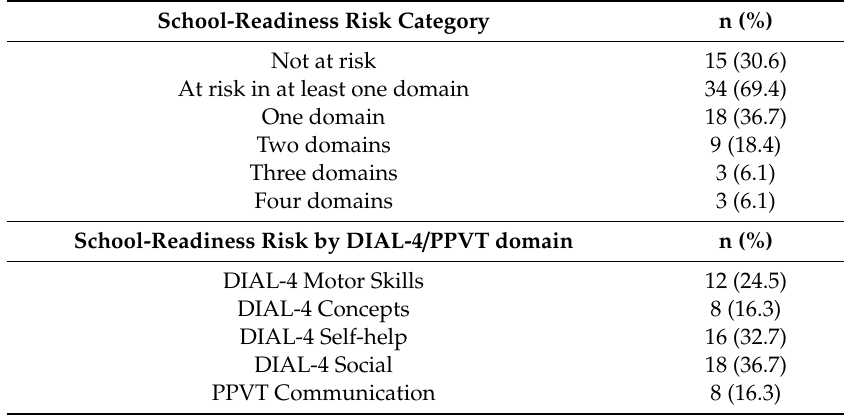
Table 4. Percentage of children at risk of school-readiness delay based on their Developmental Indicators for the Assessment of Learning—Fourth Edition / Peabody Picture Vocabulary Test (DIAL-4 / PPVT) scores (n =